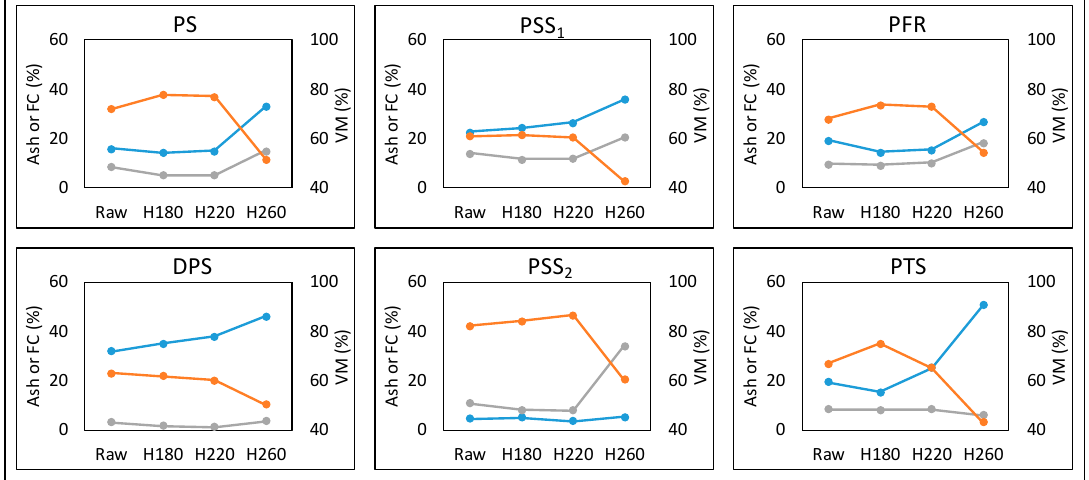
Figure 3. Proximate analysis of various paper mill sludges hydrothermally carbonized at 180–260 °C. The orange, gray, and blue lines represent volatile matter (VM), fixed carbon (FC) and ash content, respectively.